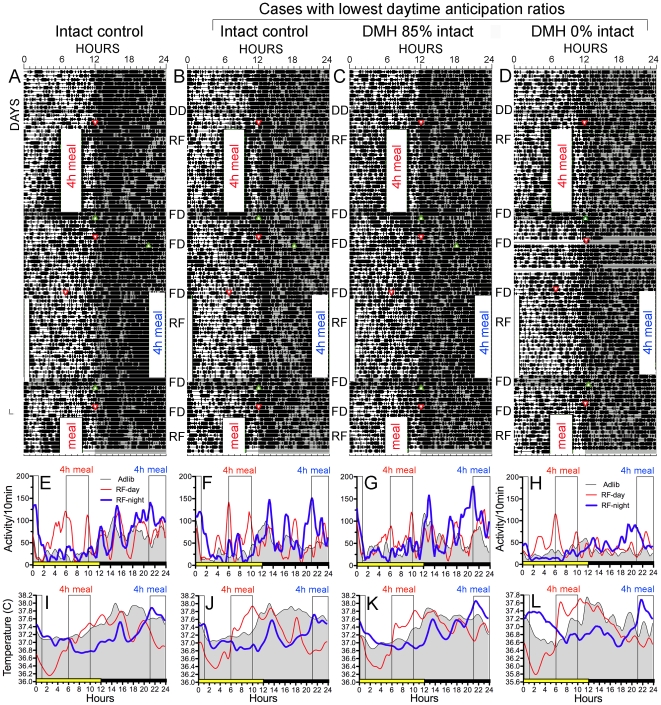
Activity and body temperature rhythms in representative intact and DMH-lesion rats.Raster plots of locomotor activity (A–D), and average waveforms of locomotor activity (E–H) and body temperature (I–L) from an intact control rat with strong daytime food anticipatory rhythms (A,E,I), an intact rat with the weakest daytime food anticipation (B,F,J; defined by the lowest food anticipation ratio during daytime feeding), the rat with the lowest daytime food anticipation ratio (C,G,K) from the group that received a low-dose ibotenic acid microinjection causing a small partial lesion, and the rat with the lowest daytime food anticipation ratio (C,G,K) from among rats receiving a high-dose lesion that induced a complete DMH lesion (Fig. 1C,F). The raster plots illustrate activity summed in 10 min bins. Each line represents 24 h of recording, with time of day plotted from left to right (144 time points/day), and consecutive days aligned vertically. Time bins in which activity counts were registered are represented by a heavy bar, the height of which signifies the amount of activity (1–10 counts, 11–20 counts and >20 counts/10 min). Grey shading denotes lights-off (hours 12–24 of LD, or all day during constant dark tests). Scheduled mealtime during food restriction are denoted by opaque columns labeled ‘4-h meal’, with red signifying a daytime meal (hours 6–10 of the light period) and blue signifying a late nighttime meal (hours 21–01). Small red arrowheads pointing down denote beginning of total food deprivation test, and small green arrowheads pointing up denote the end of food deprivation. Waveforms of activity (E–H) and temperature (I–L) data were creating by averaging across 5 days of ad-lib food access prior to food restriction (grey shaded waveforms), the last 5 days of the daytime feeding schedule (light weighted red lines) and the last 5 days of the nightime feeding schedule (heavy weighted blue lines). 4-h mealtimes are denoted by the translucent columns. The daily lights-on period is denoted by the yellow horizontal bar above the x-axis. To improve the clarity of the waveforms, the data were subjected to a second order smoothing polynomial averaging across 4 neighbouring data points (Prism 5.0 for Mac OS X). Raw (unsmoothed) data were used for the raster plots and statistical analyses.